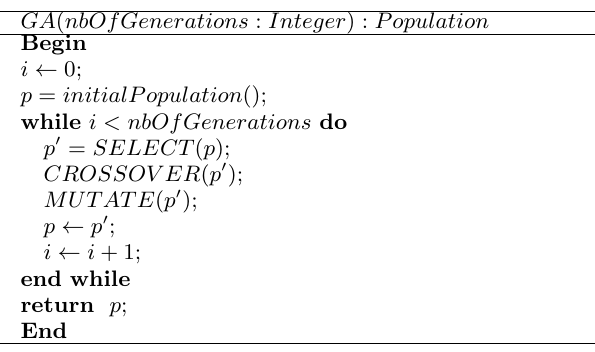
Figure 3: Genetic Algorithm